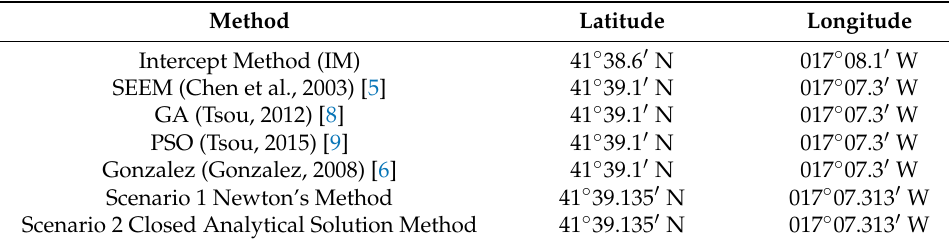
Figure 7. The GUI of Newton’s method calculation program (for Example 1). Table 3. The results of Example 1 of two-body fix positions.